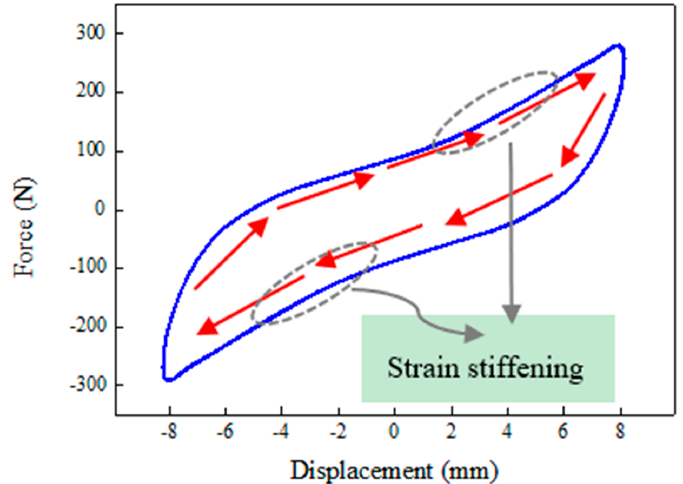
Figure 12. Dynamic responses of the MRE isolator under 4 Hz excitation frequency, 8 mm loading amplitude, and 2 A applied current. ( a ) Force–displacement loop, and ( b ) force–velocity